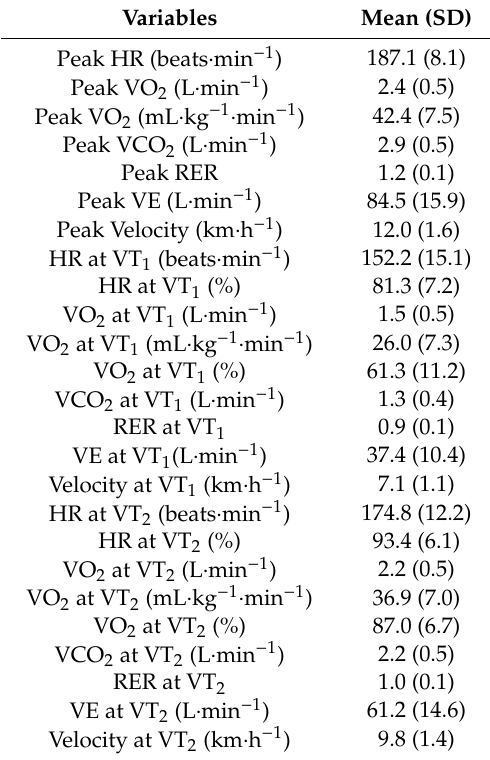
Table 1. Cardiorespiratory results attained during the incremental treadmill test.